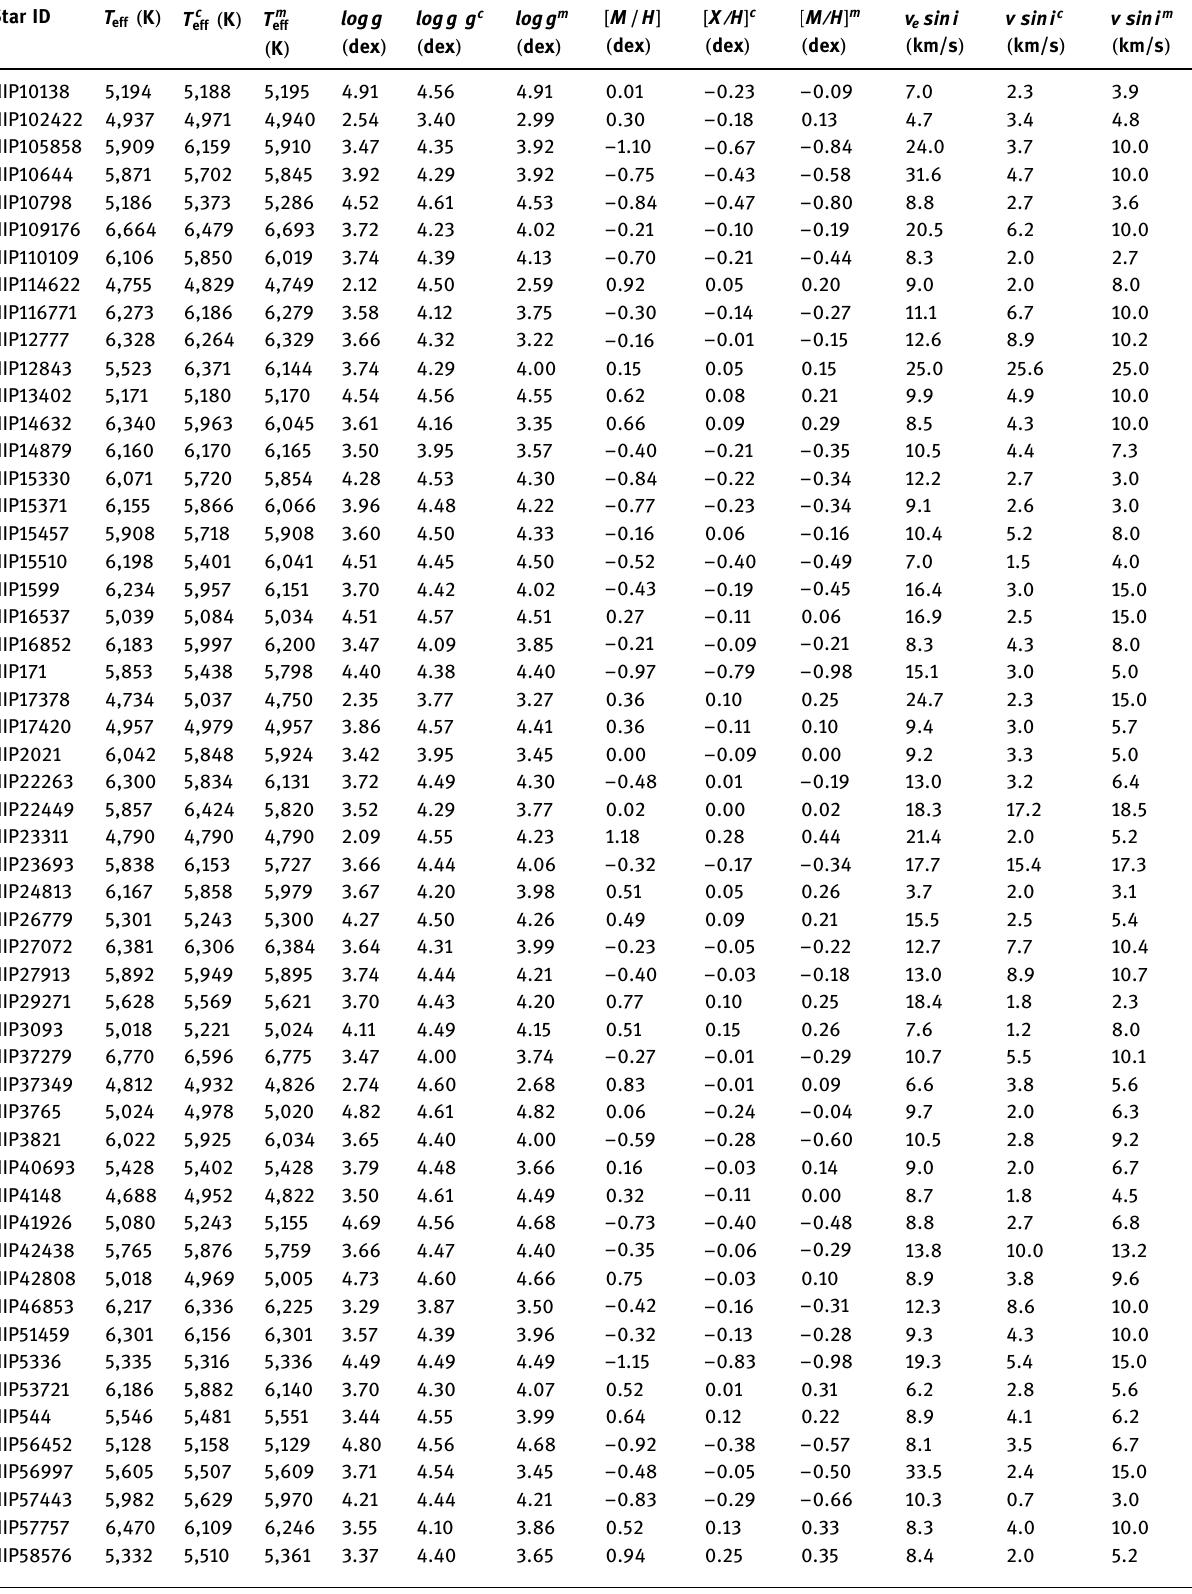
Table A2: Predicted values for T eff , g log , [ ] / M H , and v i sin e for FGK stars with the median and closest values from Vizier cataloge Star